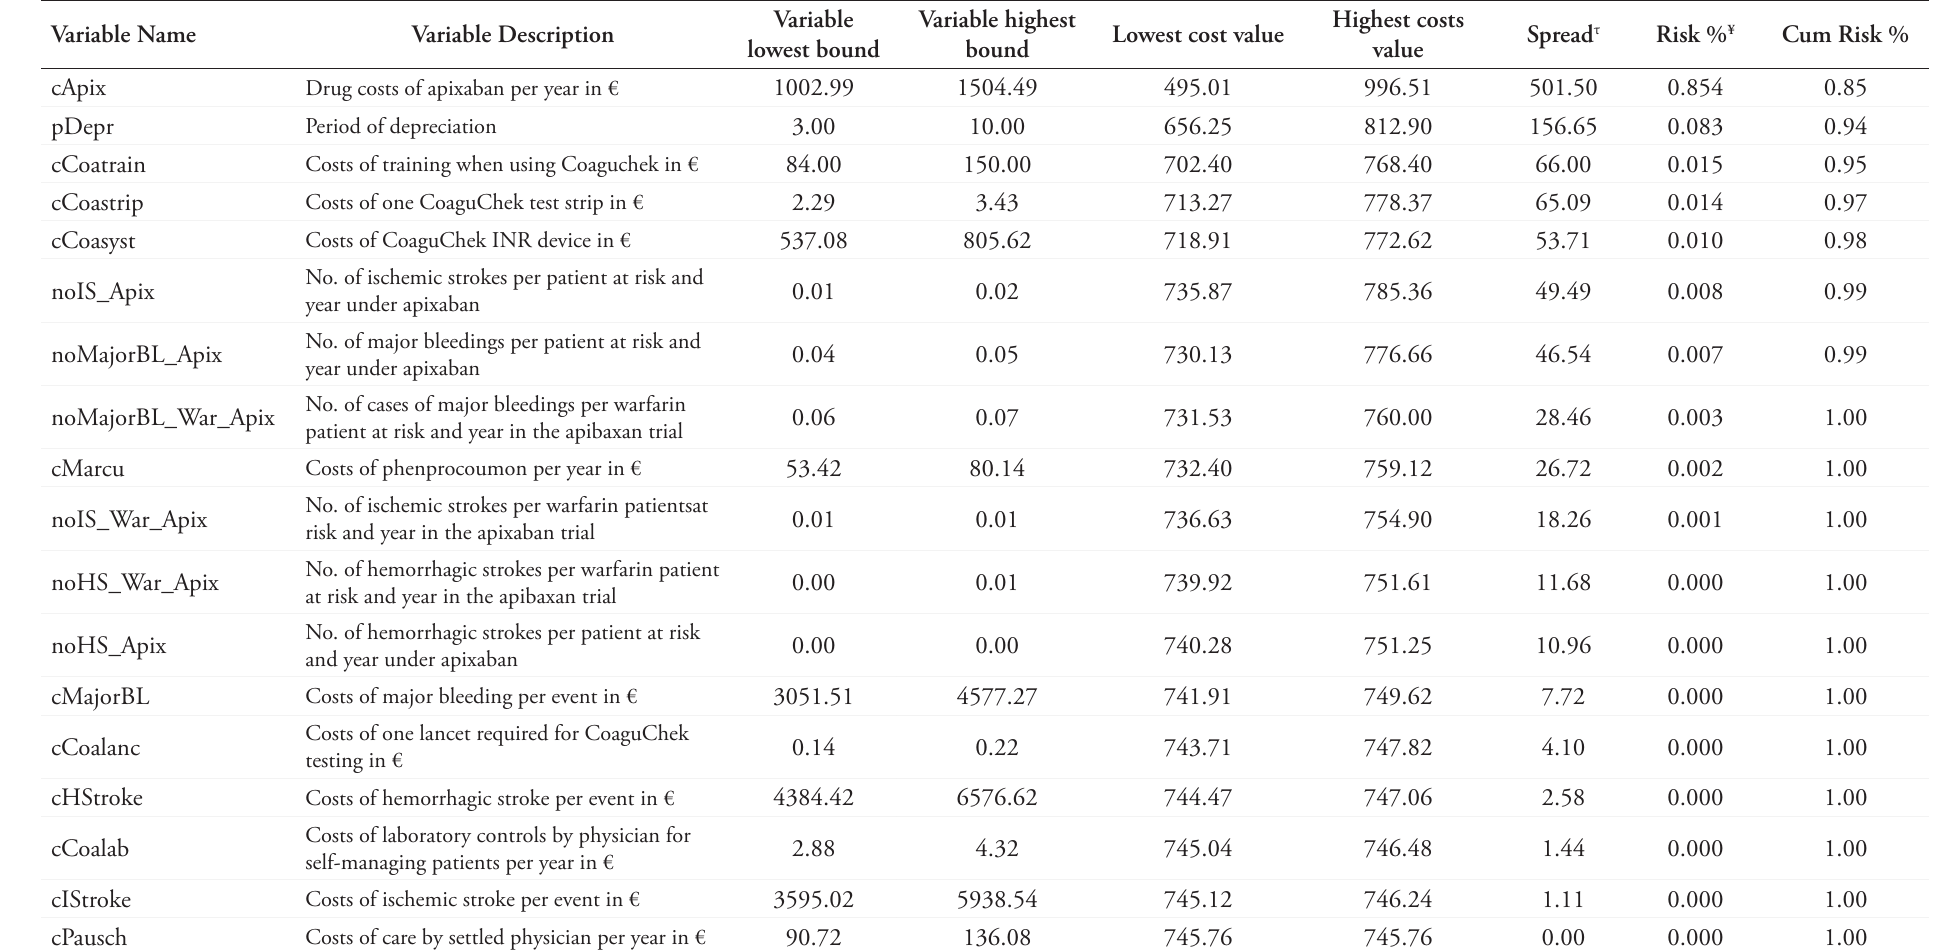
Table 5a: Tornado diagram*: VKA under PST versus